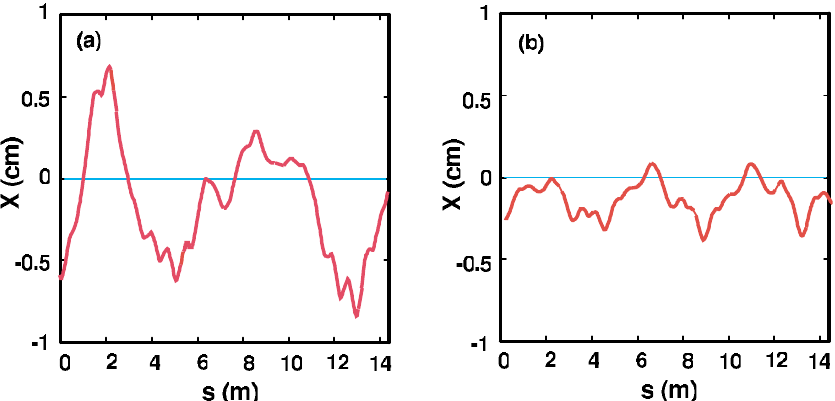
FIG. 3. (Color) Final-lap “histories” of beam-centroid displacements using (a) 18 cells per lap and (b) 10 cells per lap. Here, a velocity tilt is imposed in the first seven and first four cells, respectively, giving the nominal four-to-one reduction in beam duration.